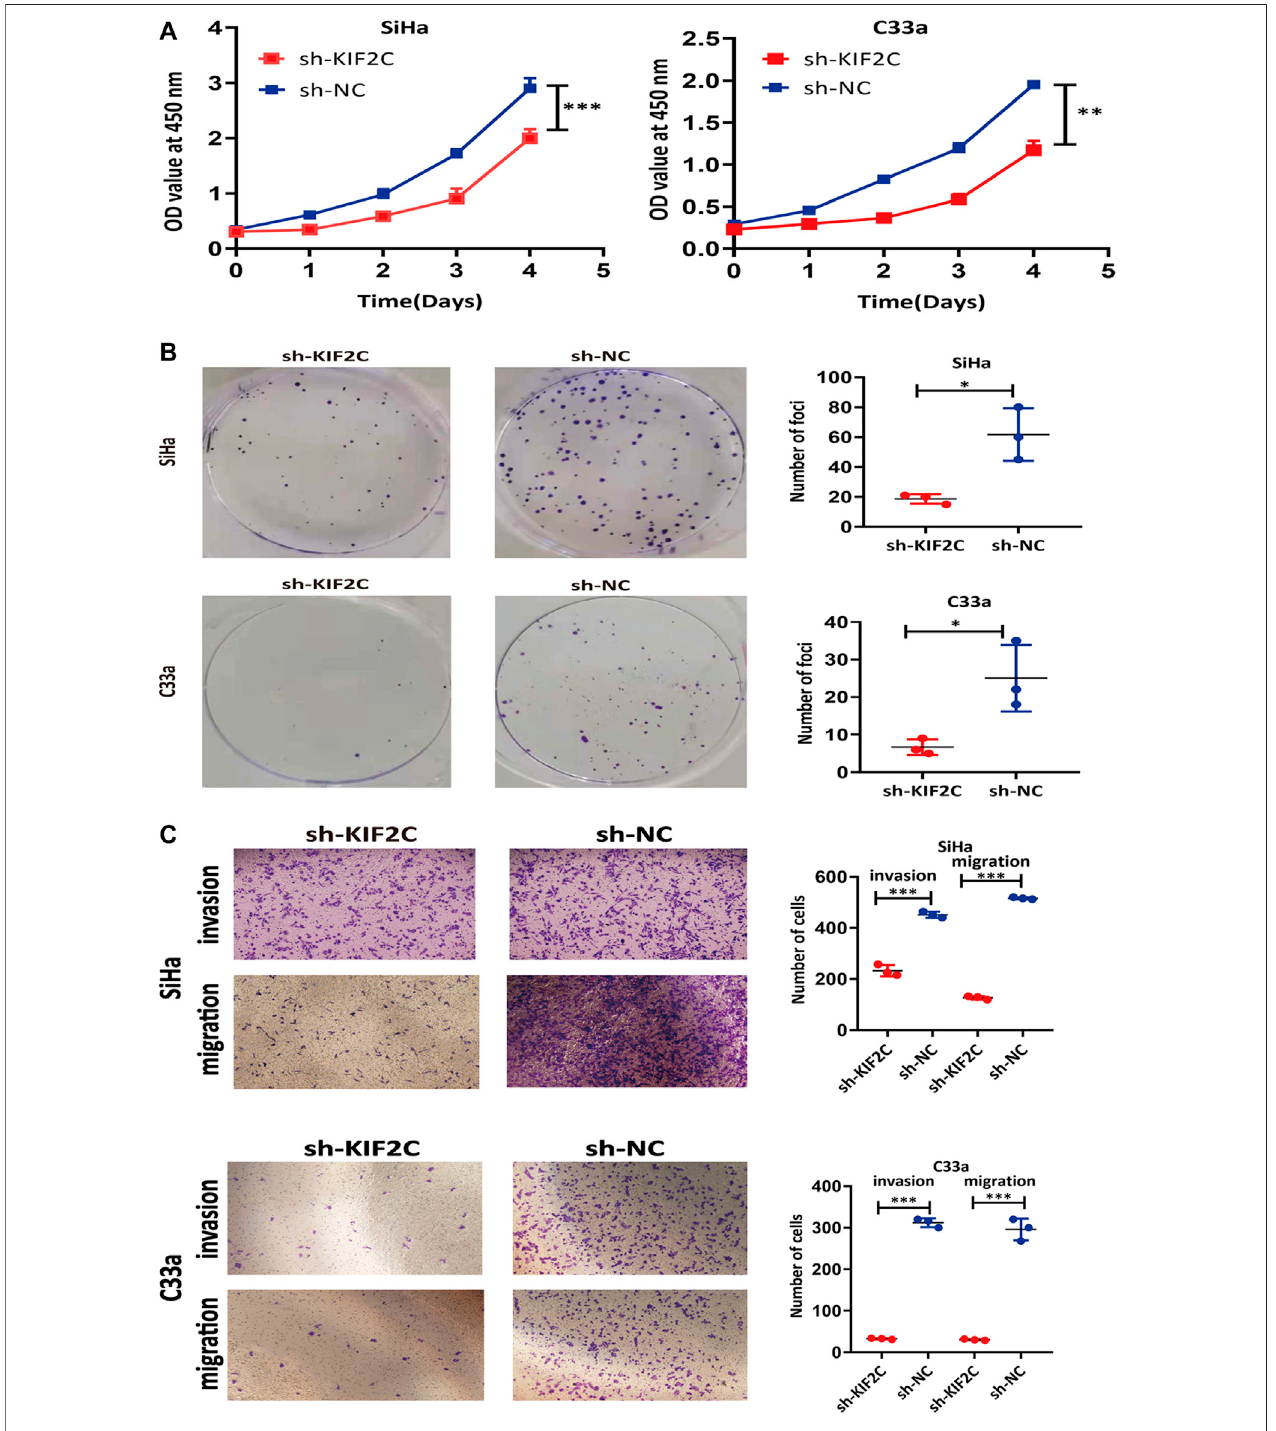
FIGURE7| KIF2C knockdowninhibitedtumorigenicityofcervicalcancercells.CCK-8assay (A) andcolonyformationassay (B) wereusedtoevaluateabilityofcell proliferation in cervical cancer cells with KIF2C knockdown; dot plots in right showed results of quantitative analyses. (C) Migration and invasion of cervical cancer cells were determined after KIF2C knockdown and quanti fi cation of number of cells in migration and invasion. * p < 0.05; ** p < 0.01; *** p < 0.001.